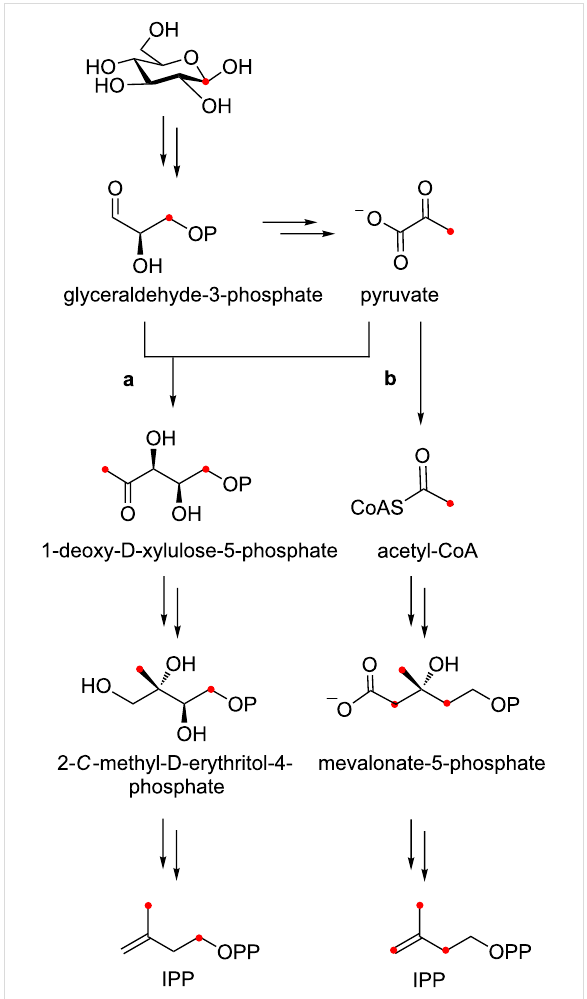
Figure 1: Distribution of isotopic labels from [1- 13 C]-glucose via the MEP (route a) and MEV pathway (route b). Potentially labeled carbon atoms are highlighted with red